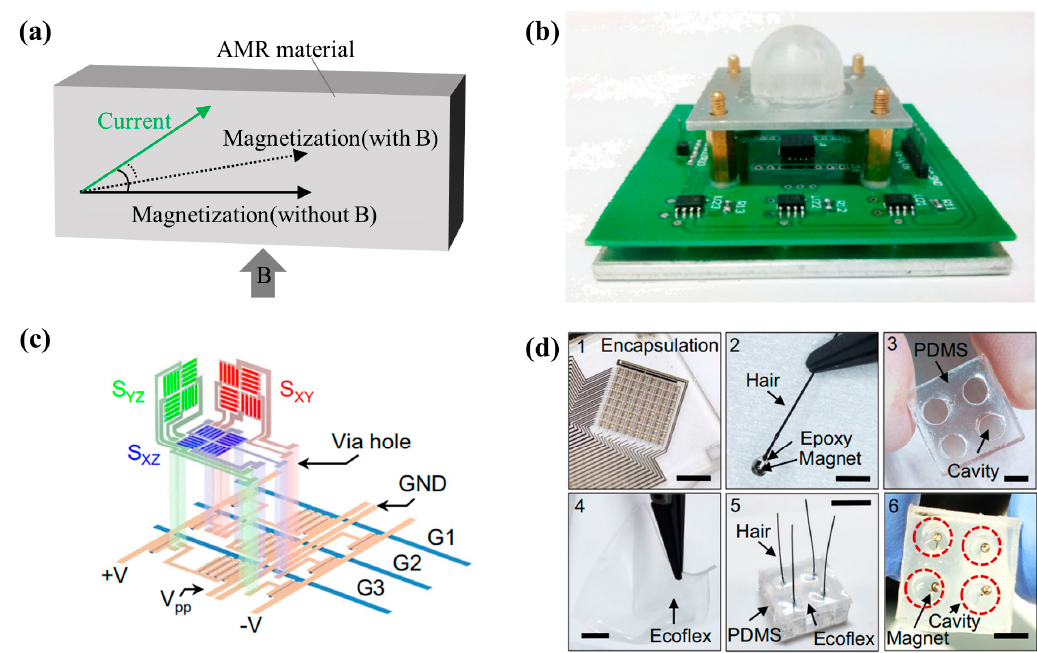
Figure 2. ( a ) Illustration of AMR effect; ( b ) Tactile sensor with a commercial 3-axis AMR sensor (designed by Ping Yu). Reprinted with permission from Ref. [53]. Copyright 2014, Springer Nature; ( c ) Three-dimensional sensitive structure of the tactile sensor with AMR film (designed by Christian Becker). Reprinted with permission from Ref. [55]. Copyright 2022, Springer Nature; ( d ) Manufac- turing process of the sensor. 1, The three-dimensional AMR sensor array is encapsulated by epoxy. Scale bar, 4 mm. 2, A small magnet is adhered to a hair and embedded in epoxy. Scale bar, 2 mm. 3, A spacer PDMS (polydimethylsiloxane) film with cavities is fabricated. Scale bar, 5 mm. 4, Ultra-flexible Ecoflex film is casted. Scale bar, 2 mm. 5, Magnetic hair, PDMS spacer and Ecoflex skin are assembled. Scale bar, 15 mm. 6, Bottom view of the skin layer showing that the magnets are hold within the cavities of the PDMS spacer. Scale bar, 5 mm. Reprinted with permission from Ref. [55]. Copyright 2022, Springer Nature.